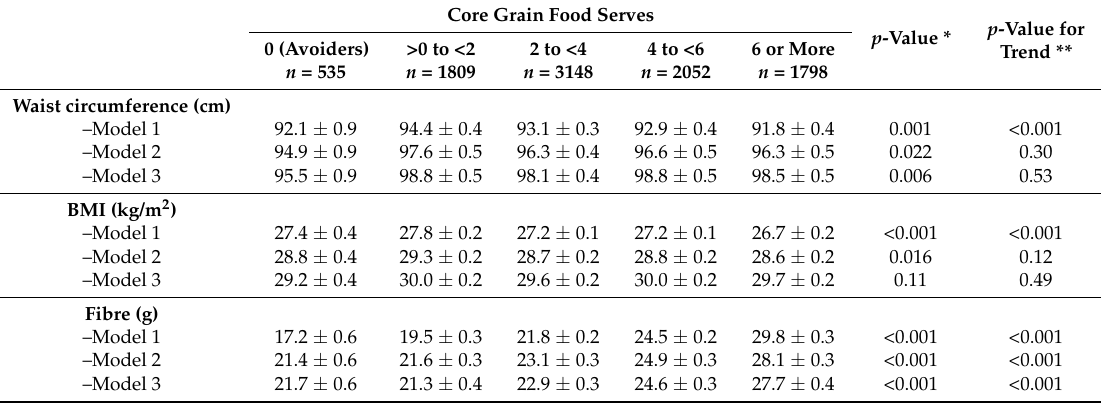
p -Value * p -Value for Trend **0 (Avoiders)